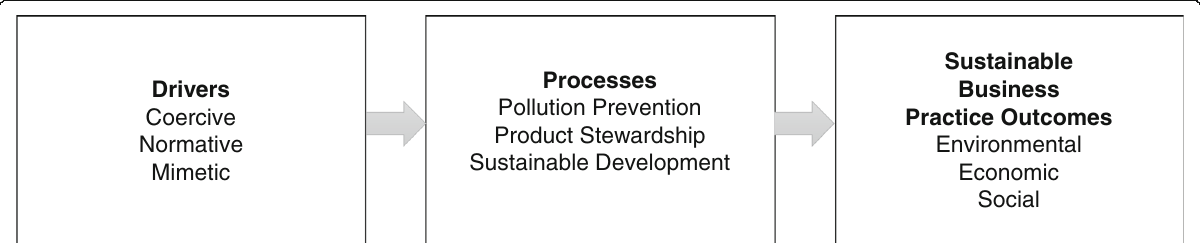
Fig. 1 Conceptual framework for exploring the two case